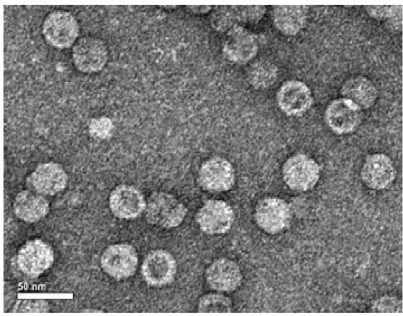
Figure 4. Electron microscopy of EV71 VLPs. Partially purified VLPs were negatively stained with 0.5% aqueous uranyl acetate and visualized by transmission electron microscopy. Bar=50 nm.